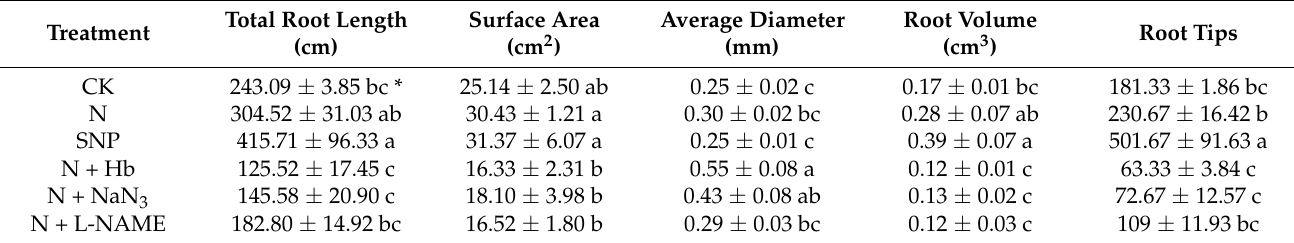
Figure 2. Effects of different ammonium/nitrate ratios, exogenous nitric oxide, and the addition of NO scavenger and biosynthesis inhibitors in ammonium/nitrate solution on shoot and root morphology of mini Chinese cabbage seedling exposed to low-light stress. Root morphology of 8-day-old mini Chinese cabbage seedlings cultivated in hydroponics system and fertilized with the above-treated solutions. The photographs were obtained by scanning roots with root system scanner (Expression 11000XL, EPSON) and used to analyze root morphological parameters by software Win RHIZO version 5.0 (Regent Instruments, Inc., Quebec, G1V 1V4, Canada). Table 2. Effects of exogenous nitric oxide, different ammonium/nitrate ratios, and the application of NO scavenger and biosynthesis inhibitors in ammonium/nitrate solution on root morphological parameters in Brassica pekinesis exposed to low-light